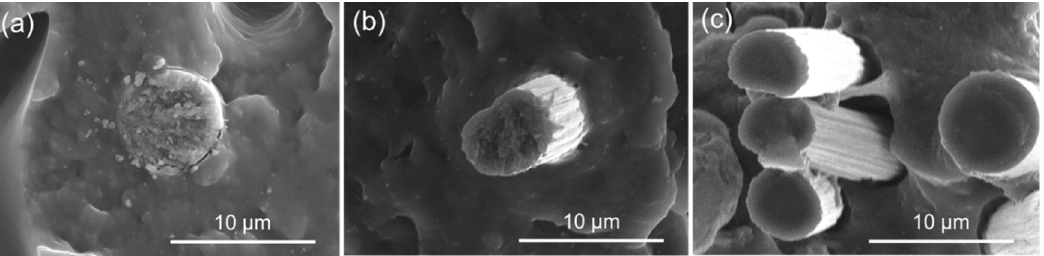
Figure 13. Fracture mechanisms observed on 0° layers. ( a ) Fiber breakage; ( b ) Limited debonding leading to breakage; ( c ) Extensive debonding leading to fiber pull-out.